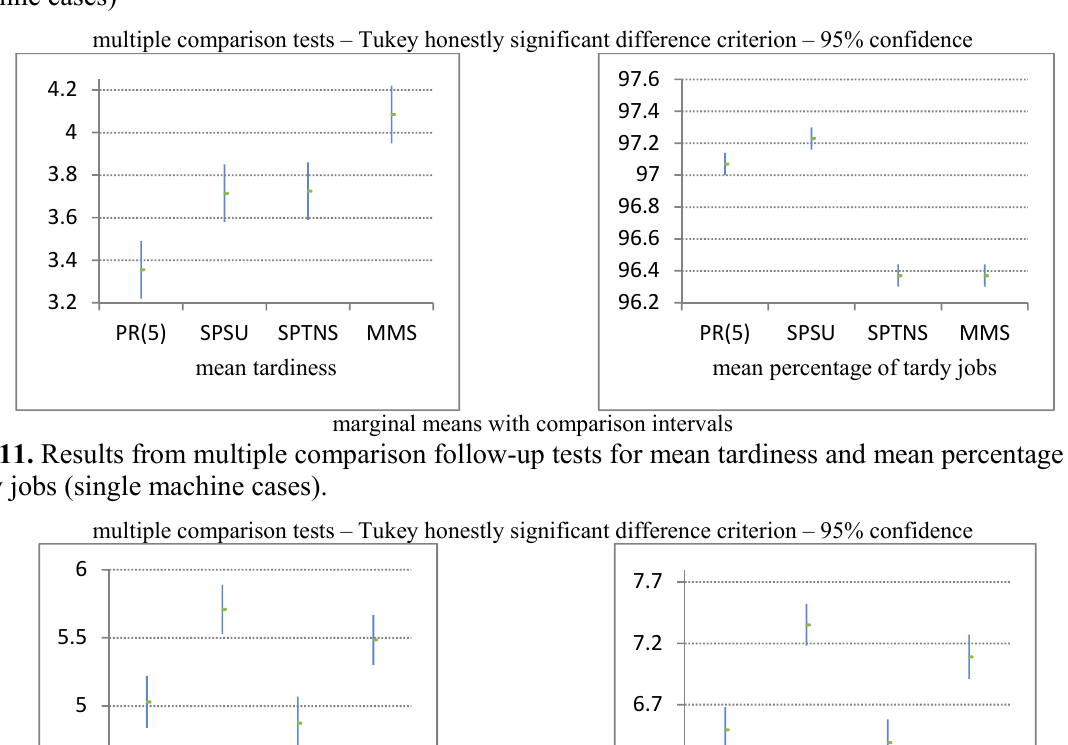
Fig. 10. Results from multiple comparison follow-up tests for mean WIP and mean cycle time (single machine cases)